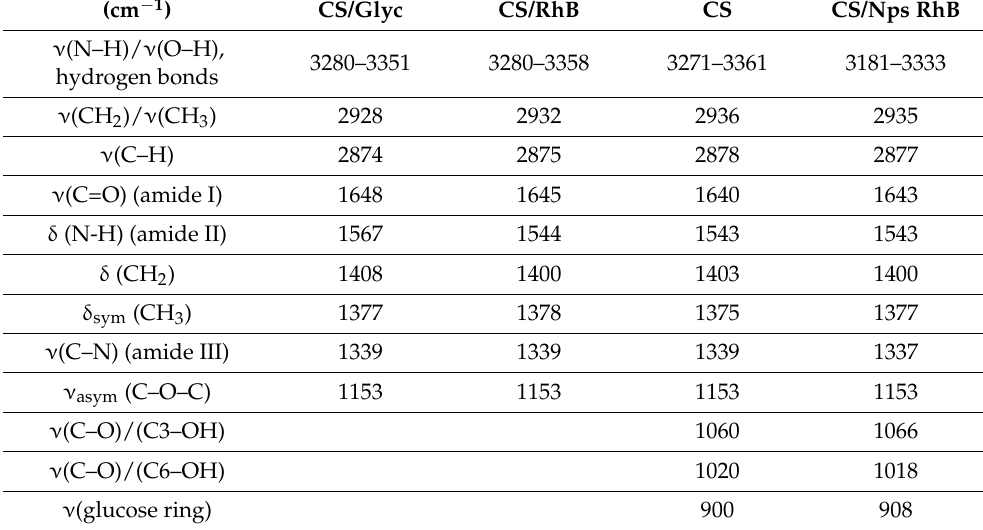
Table 2. ATR-IR absorption bands and assignments (cm − 1 ) of hydrogel films.